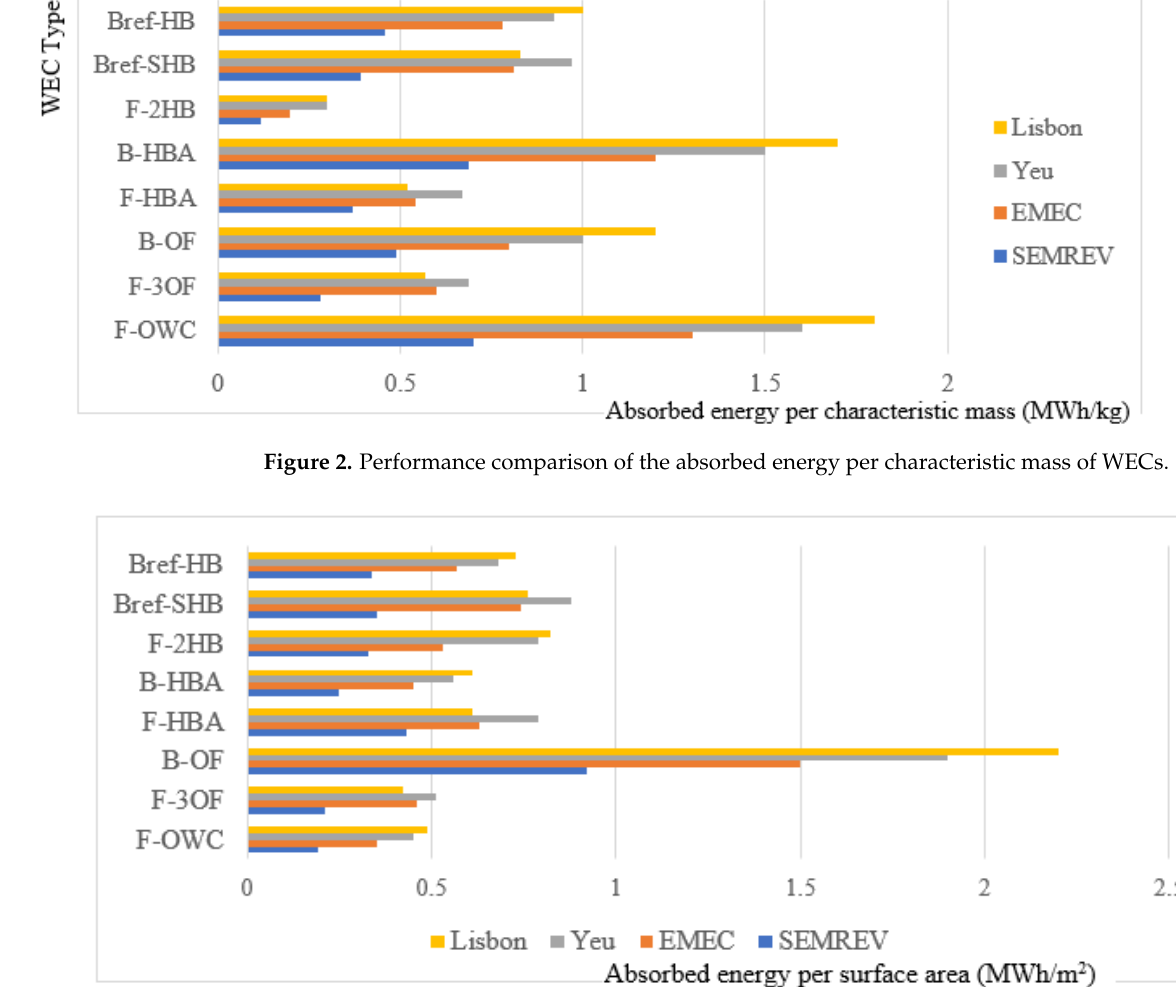
Figure 4. Performance comparison of the absorbed energy per RMS of PTO force of WECs.